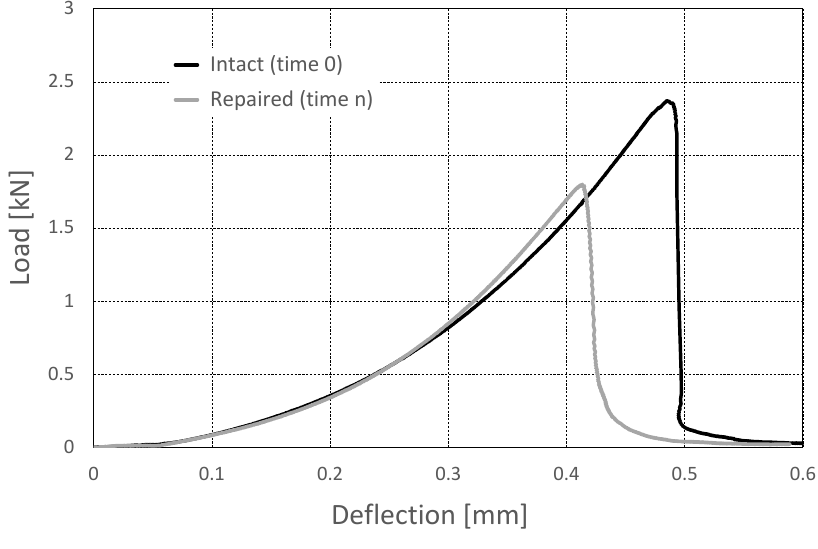
Figure 11. Load versus deflection curves from three-point-bending tests in the intact state (solid black line) and in the damaged state (solid gray line).